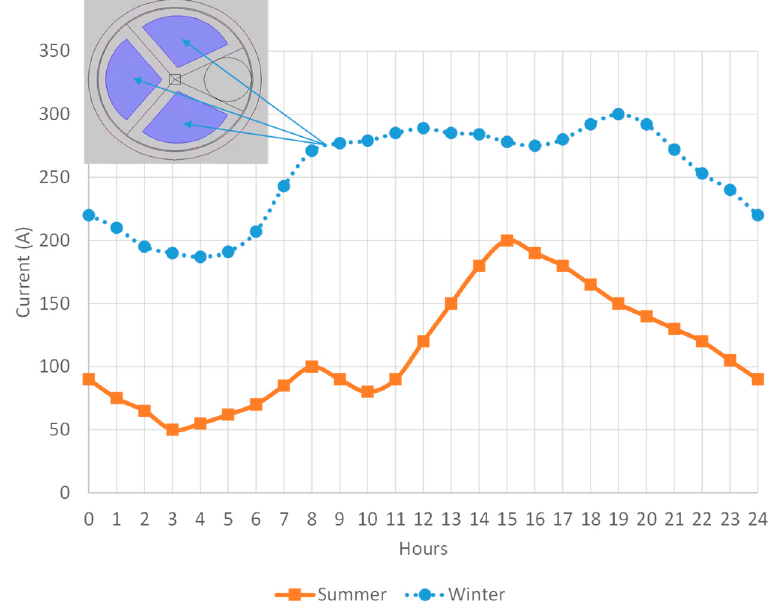
Figure 10. Current flow for one day in each phase of the conductors in summer and winter [32].